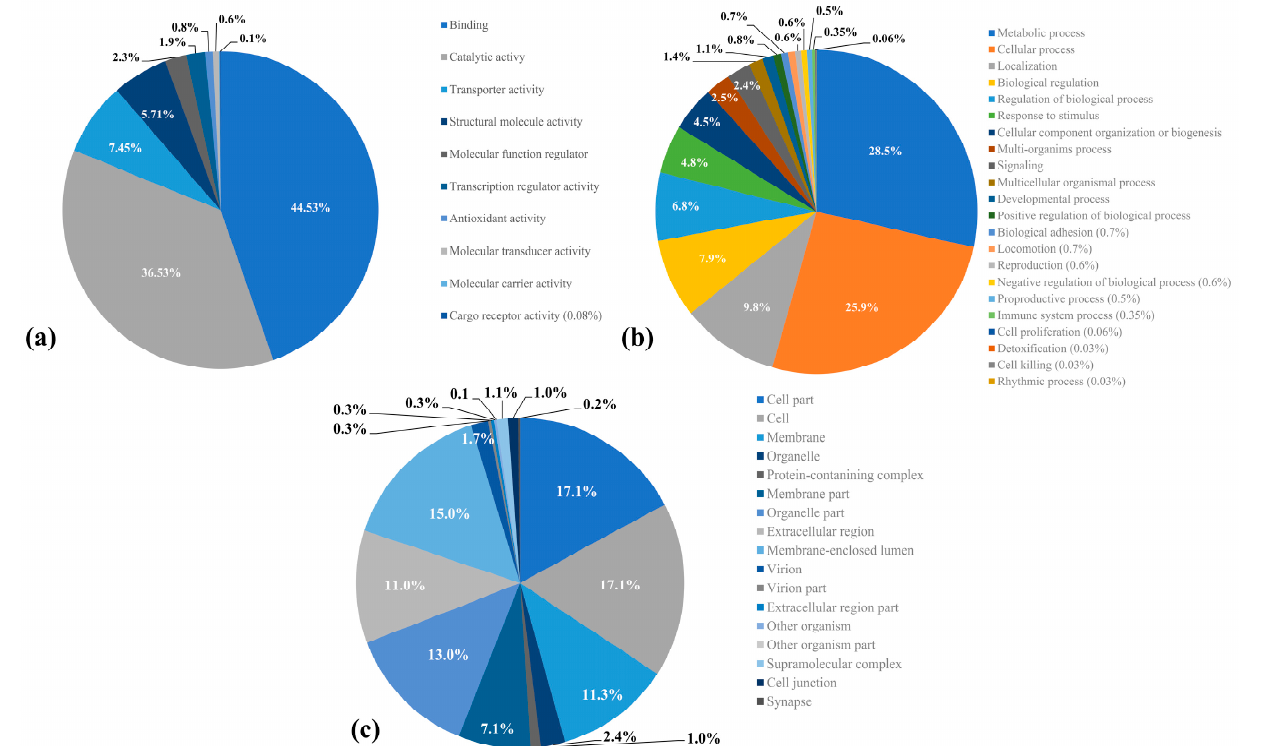
Figure 1. Gene ontology (GO terms) analysis from Anthonomus eugenii head transcriptome. The numbers within each graph represent the percentage of genes annotated for each GO term. ( a ) Molecular function level 2; ( b ) biological process level 2; ( c ) cellular component level 2. The percentages were calculated from the total genes annotated per each category.